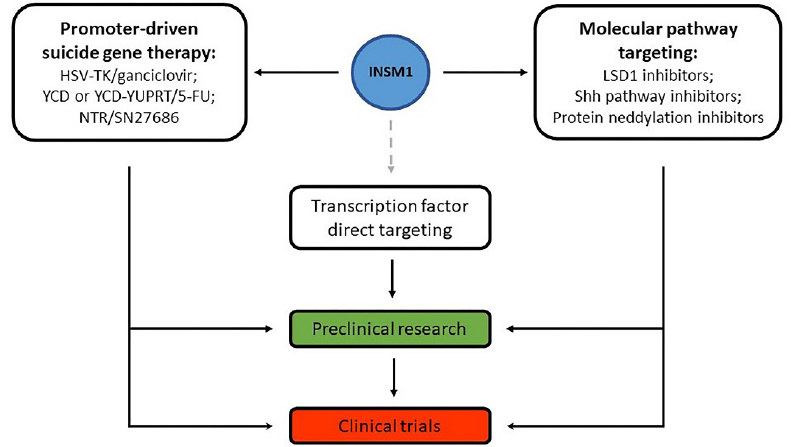
Figure 2. INSM1 treatment options in SCLC. Summary of the researched therapeutic approaches for SCLC using INSM1 . Currently, there are no studies available on INSM1 as a direct target, due to the difficult nature of targeting transcription factors [102,103]; therefore, preclinical trials would be